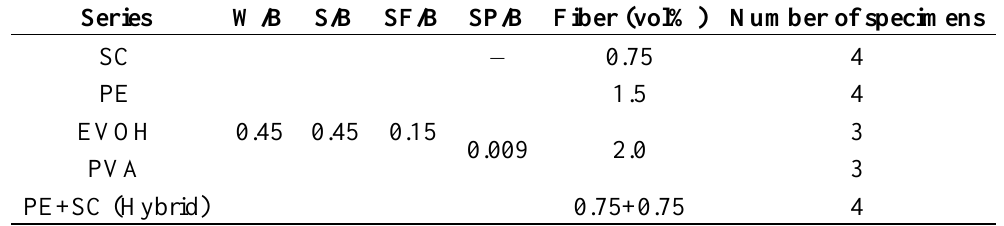
Table 1. Mixture proportions of fiber reinforced cementitious composites (FRCCs).